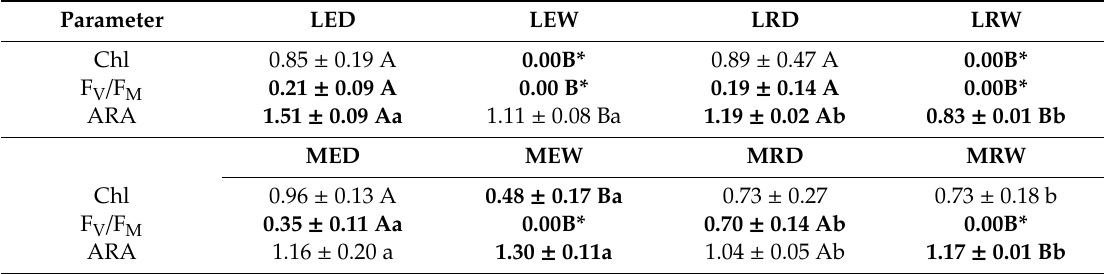
Table 1. Chlorophyll content (Chl), photosynthetic e ffi ciency (F V / F M ) and antioxidant power % (ARA) in samples of the lichen (L) Evernia prunastri and the moss (M) Brachythecium sp. exposed dry (D) or wet (W), immediately after (E) 1 h fumigation with 1 ppm O 3 or after 1 week of recovery (R). Values are expressed as median ± median absolute deviation of ratios to control values. Values in bold indicate significant ( p < 0.05) di ff erences with control values, capital letters indicate significant ( p < 0.05) di ff erences between D and W, and lowercase letters indicate significant ( p < 0.05) di ff erences between E and R. * values were almost zero and were disregarded for the statistical analysis but were considered significantly di ff erent from controls and dry samples.